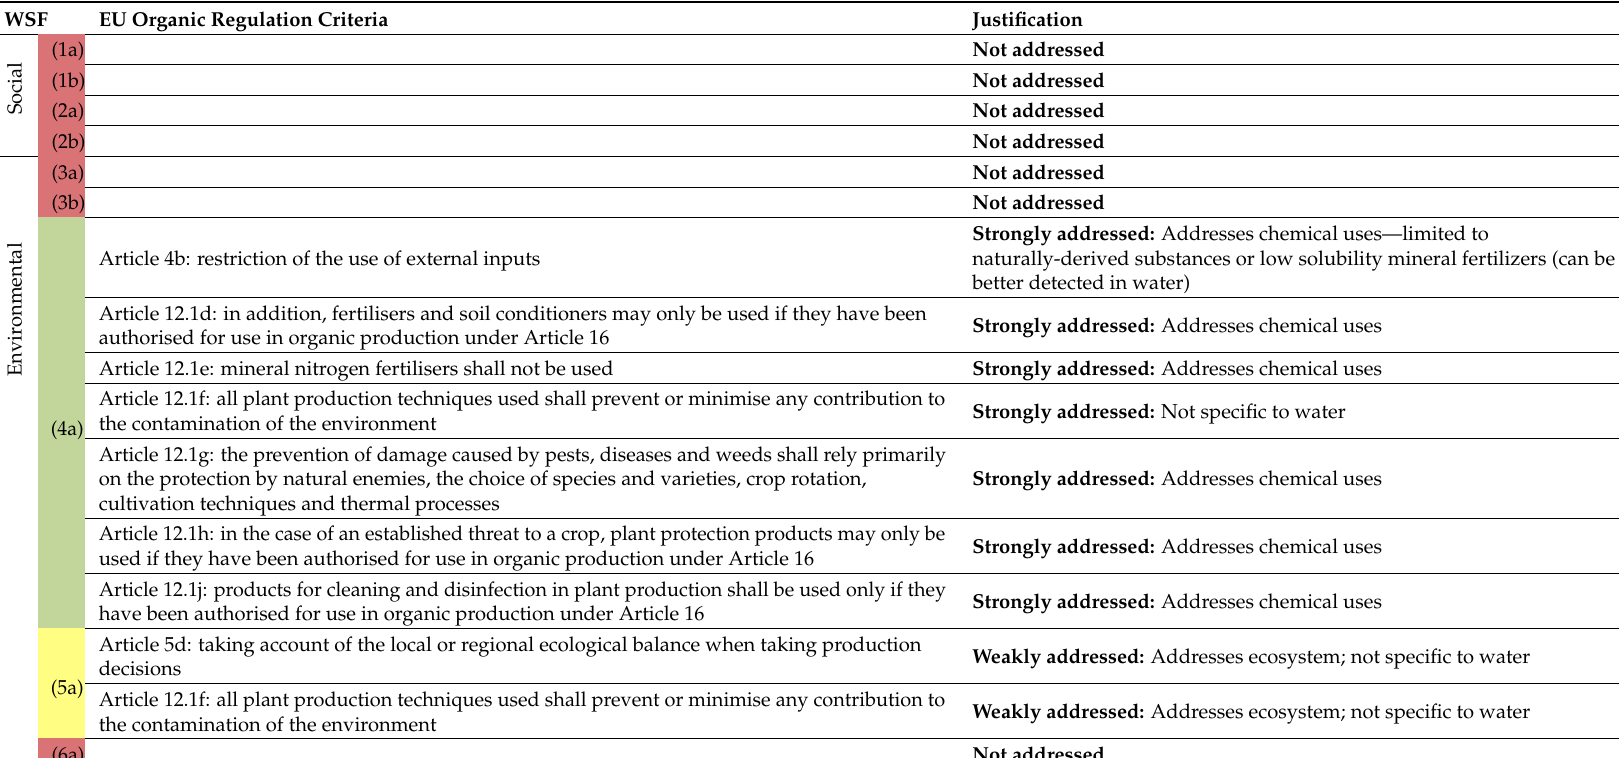
Table A4. EU Organic